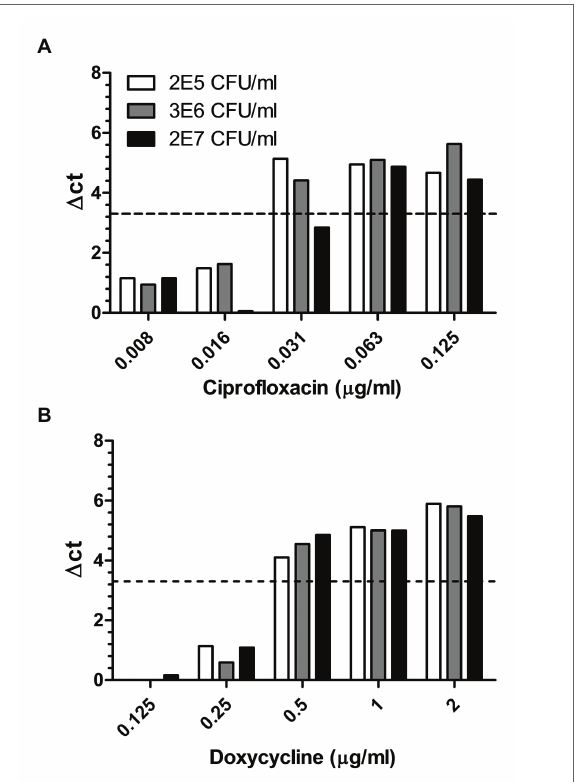
FIGURE 3 | Environmental samples spiked with different concentrations of Y. pestis . Different environmental samples spiked with 2E7, 3E6, and 2E5 cfu/ ml of Y. pestis were subjected to MAPt. MIC was determined, as described in materials and methods, by the thresholds of ∆ CT = 3.3. (A) Ciprofloxacin and (B)